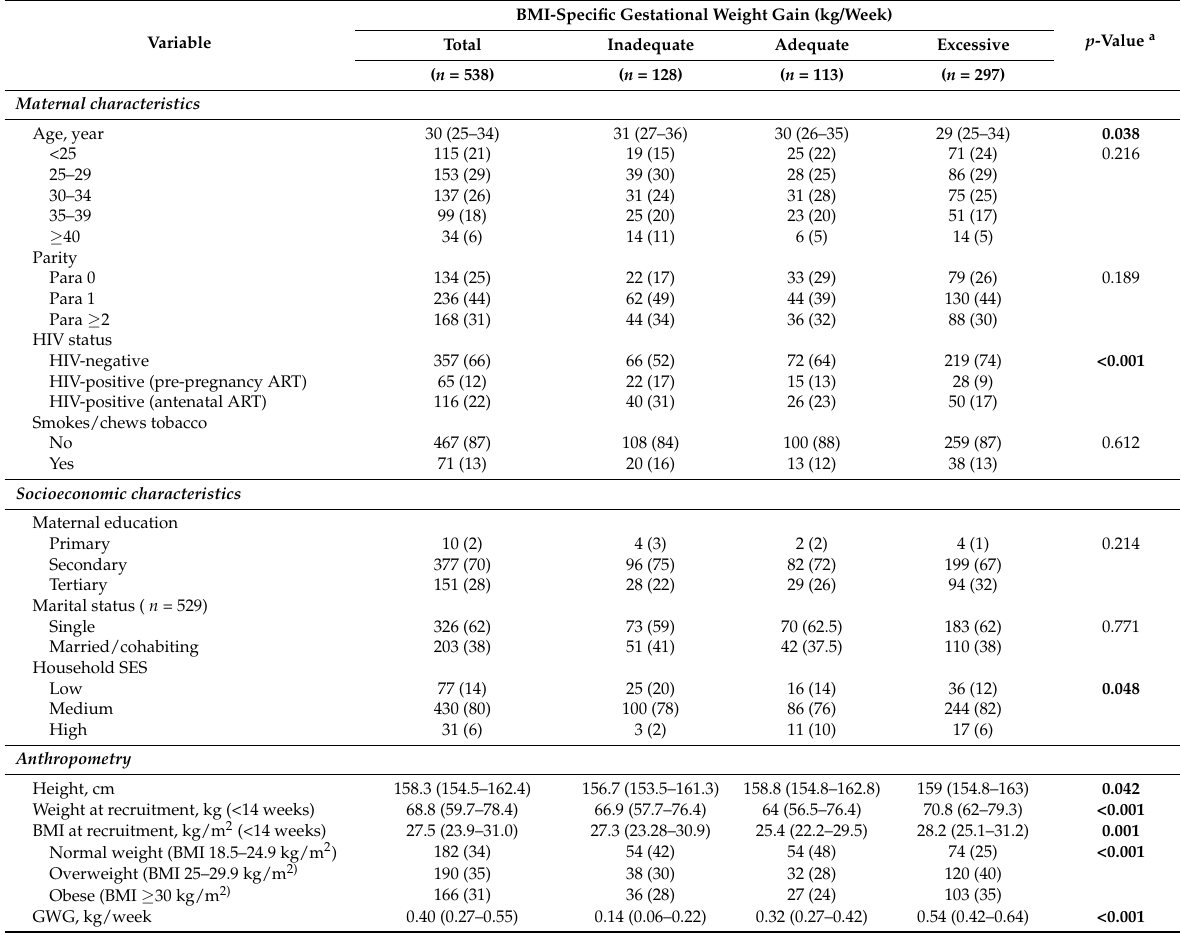
Table 1. Maternal characteristics of South African women according to Institute of Medicine (IoM) BMI-specific gestational weight gain